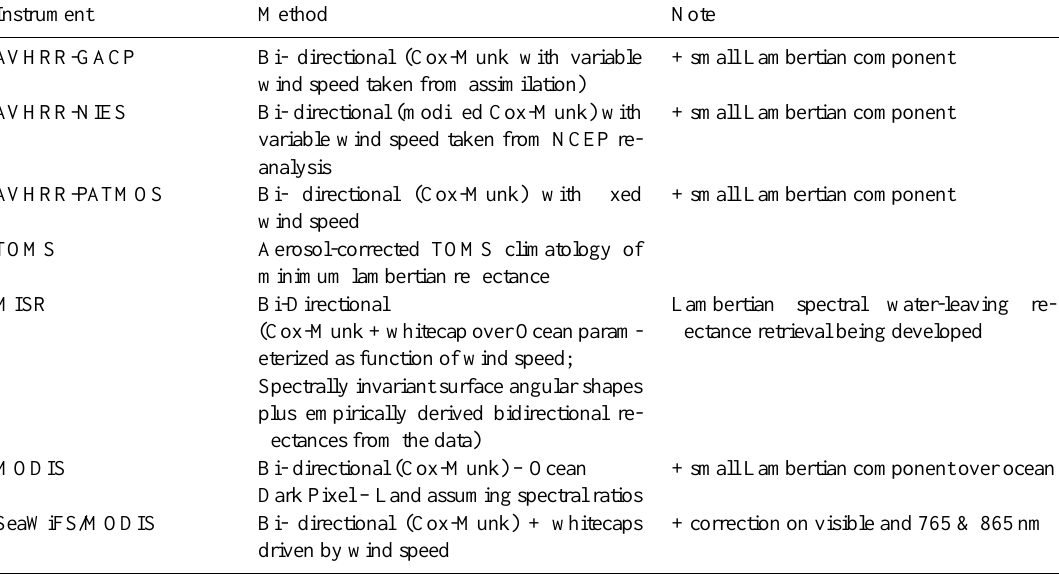
Table 4. Summary of surface treatment for the major aerosol retrieval algorithms. Instrument